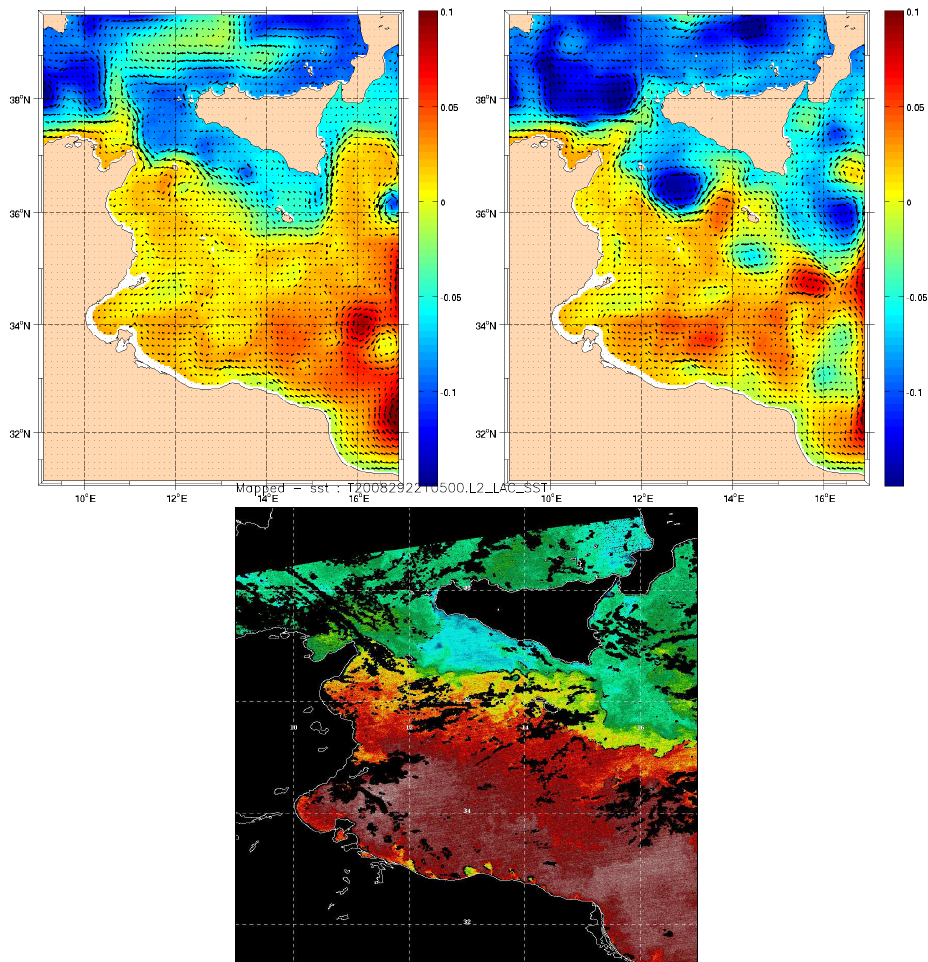
Fig. 5. 18 October 2008. Free surface elevation in cm for SIM (left) and AN (right). Bottom panel shows satellite SST.